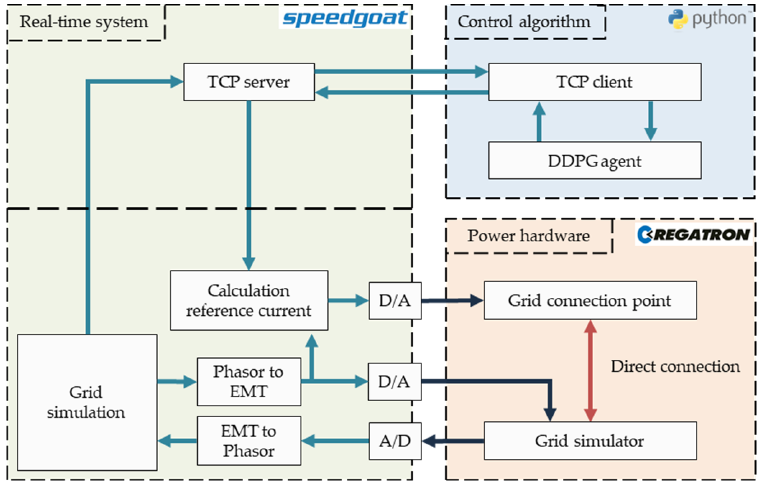
Figure 1. Integration of the DDPG agent into the PHIL environment (red: power exchange, blue: digital signal, black: analog signal).